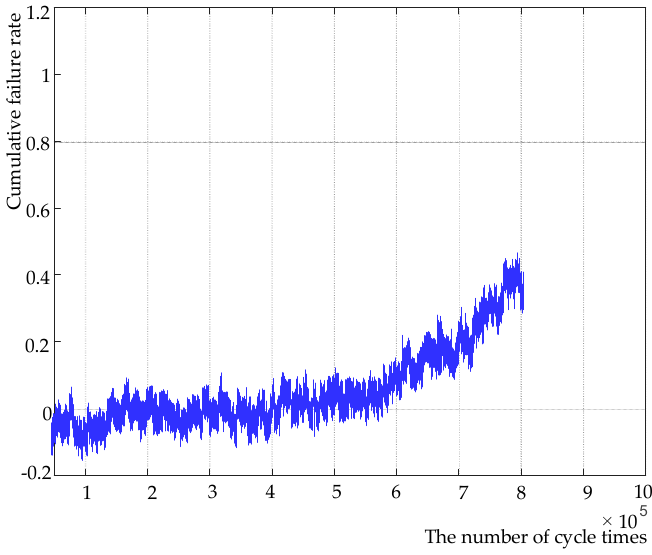
Figure 10. Curve of bi-directional aging under 900A.